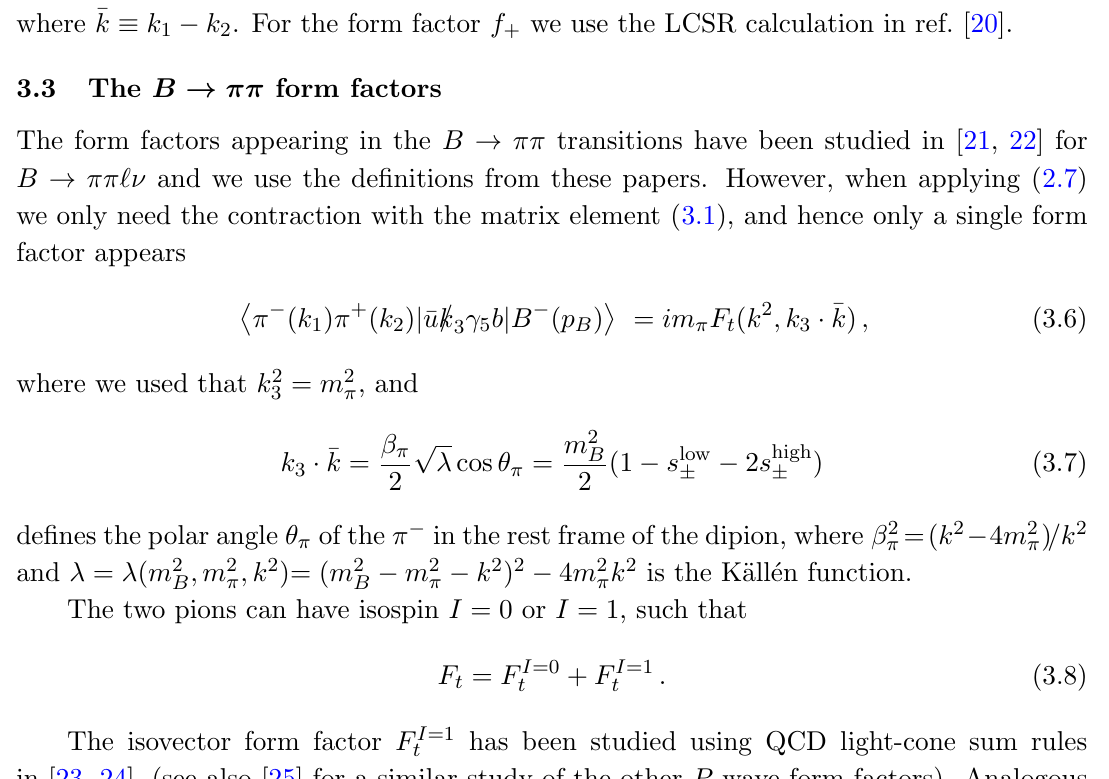
( k 2 ) = j F S j e i(cid:14) S in the time-like (cid:25) (cid:25)